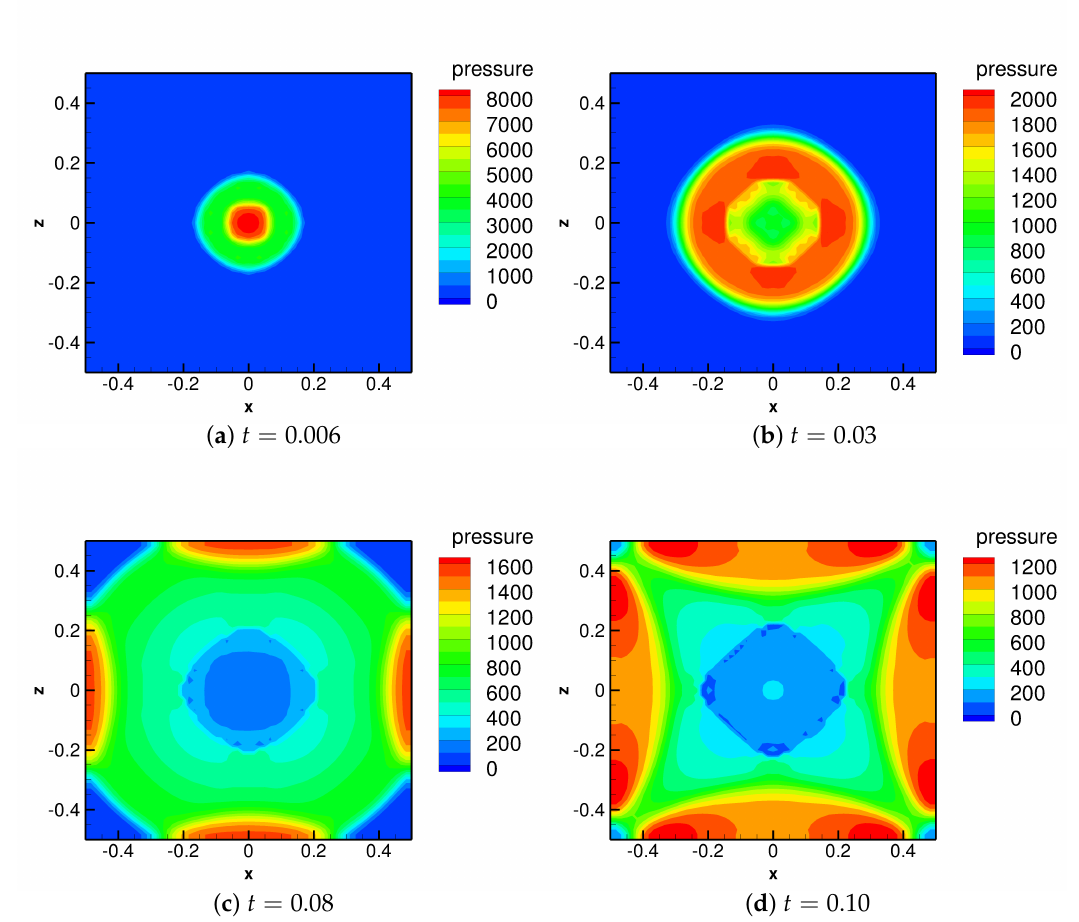
Figure 2. The temporal evolution of the pressure field for an initially spherical bubble in slice plots ( y = 0.0). Note that the range of the legend in each figure is different for a better